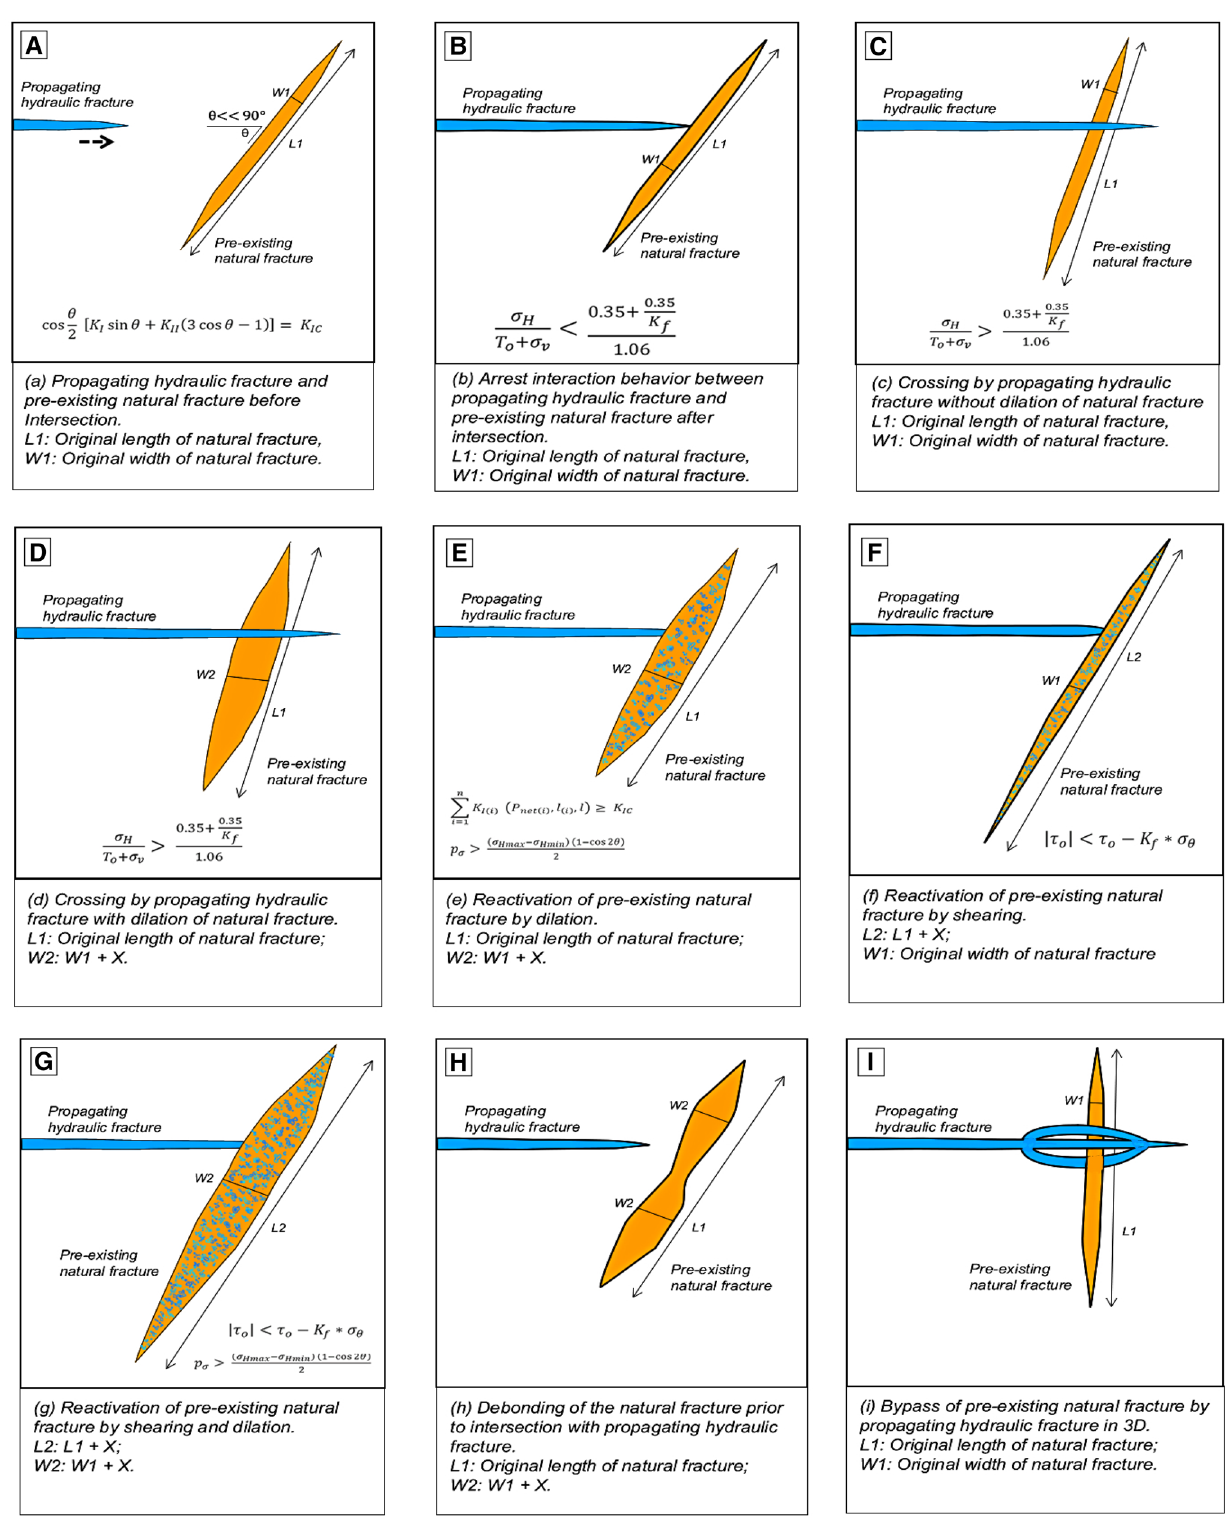
Fig. 1 Widely documented and newly observed interaction behavior between propagating hydraulic fracture and pre-existing natural